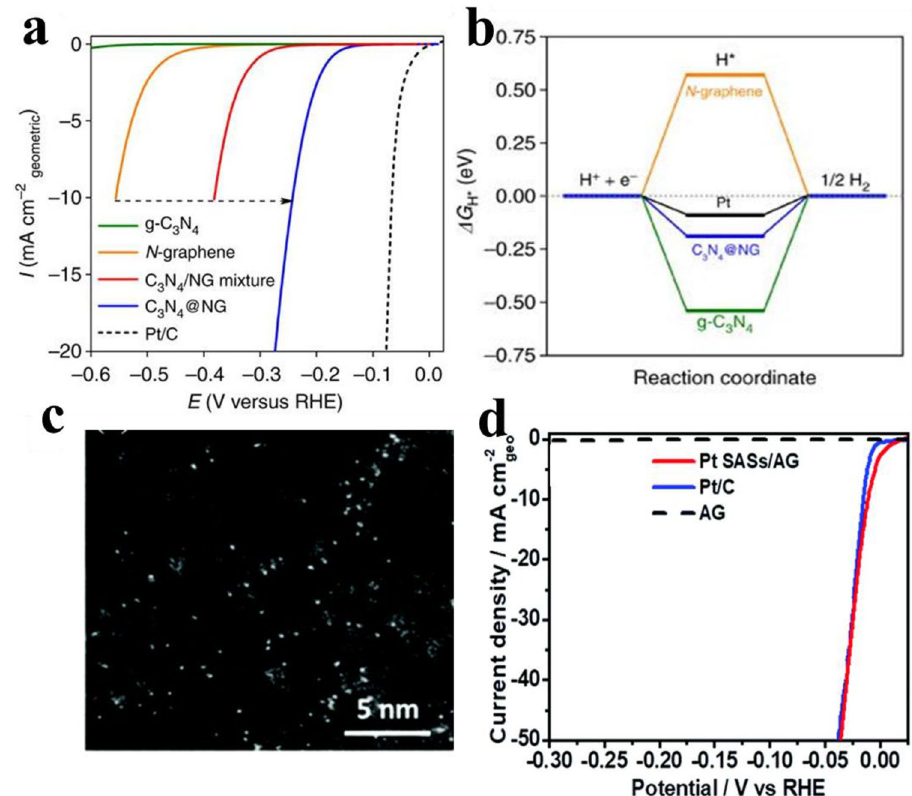
Fig. 4 a The polarization plots for g-C 3 N 4 , N-graphene, C 3 N 4 / NG mixture, C 3 N 4 @NG, and 20% Pt/C in 0.5 M H 2 SO 4 at the scan rate of 5 mV s −1 . b The free-energy diagram calculated at the equilibrium potential for N-graphene, C 3 N 4 /NG mixture, C 3 N 4 @NG, and Pt [25], c HAADF-STEM images of Pt SASs/AG. d LSV curves of Pt SASs/AG and Pt/C in 0.5-M H 2 SO 4 at the scan rate of 2 mV s −1